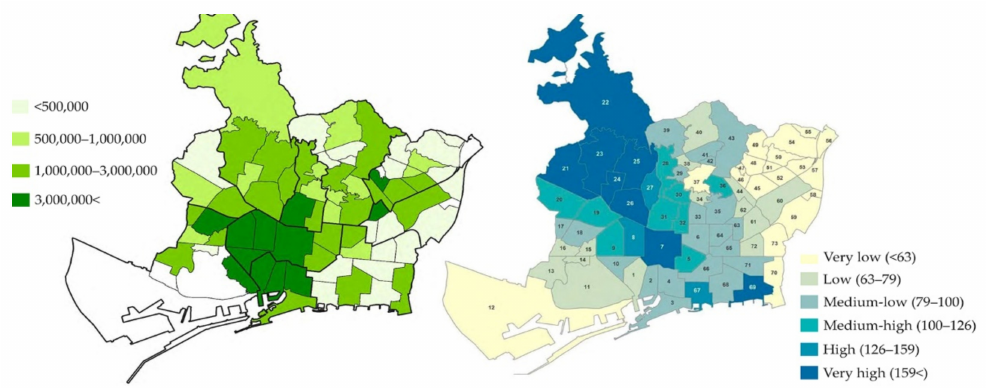
Figure 2. Subsidies granted in residential buildings, 2010–2018. Disposable household